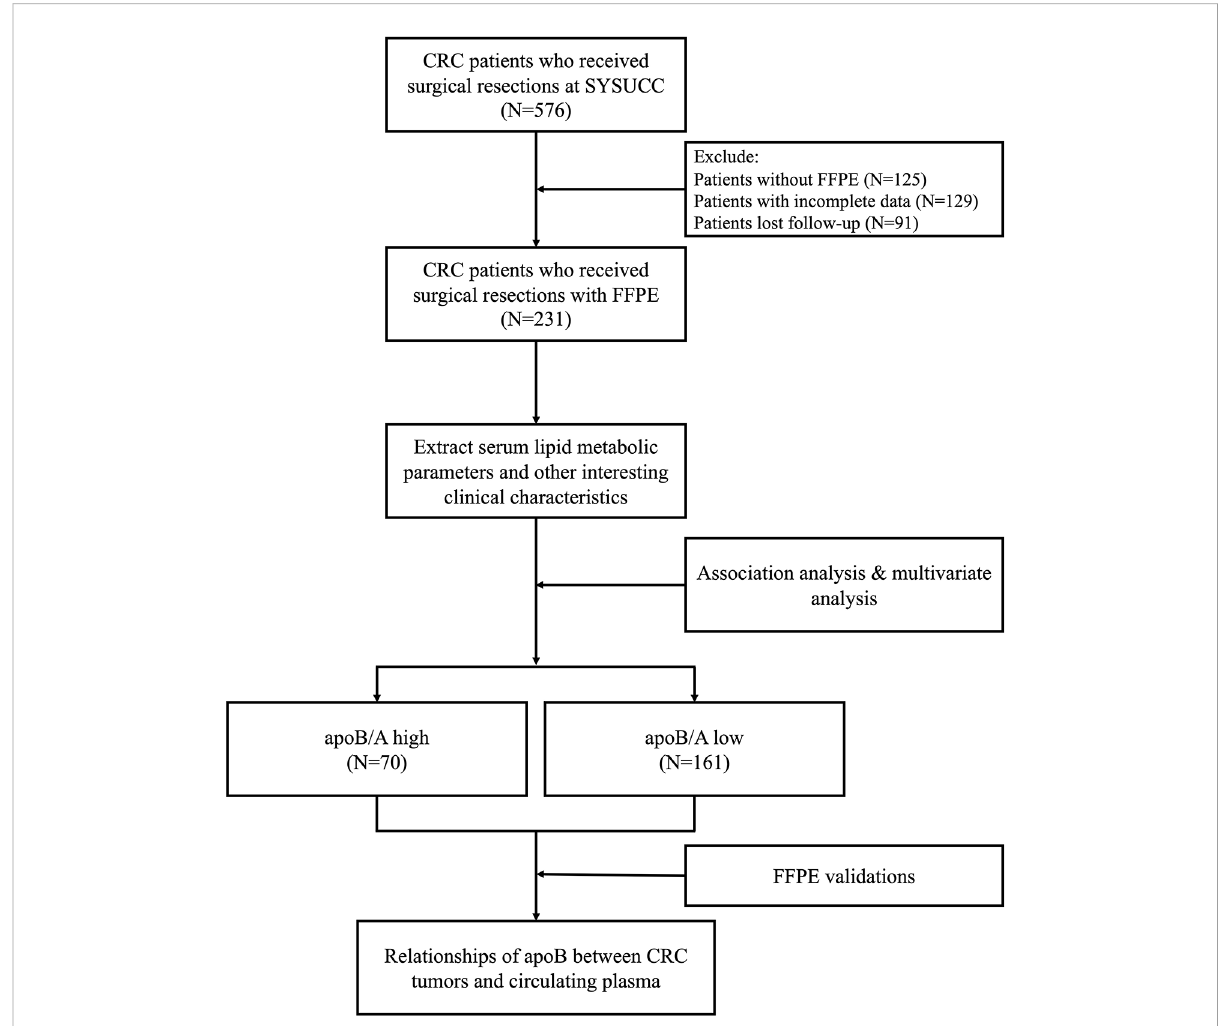
FIGURE 1 Flow chart for the current study. CRC, colorectal cancer; SYSUCC, Sun Yat-sen University Cancer Center; FFPE, formalin- fi xed paraf fi n- embedded; apoB/A, apolipoprotein B and apolipoprotein A-I ratio; apoB, apolipoprotein